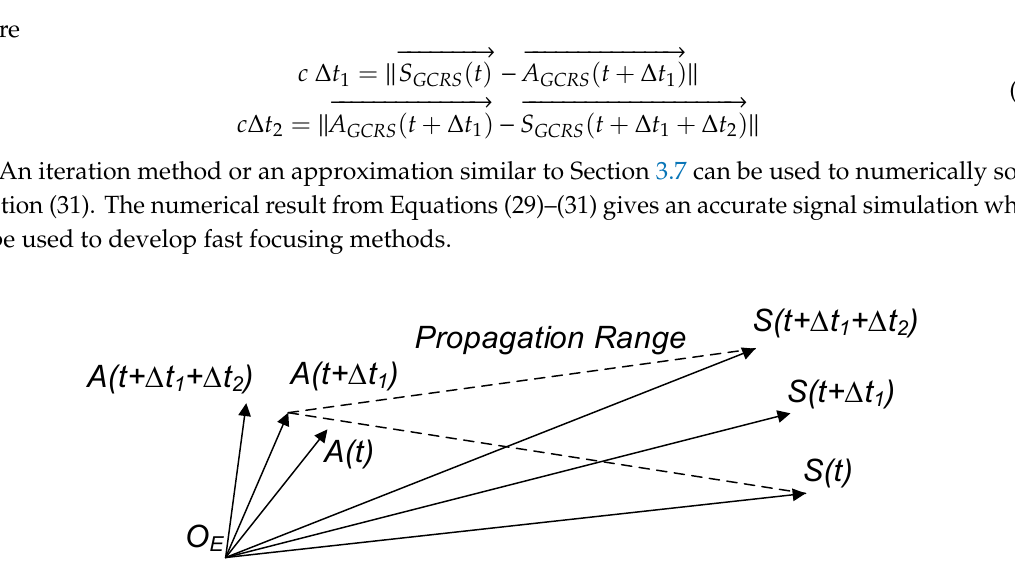
Figure 12. The moon-based synthetic aperture radar (SAR) geometric model in the GCRS. The dashed line indicates the round-trip propagation range.